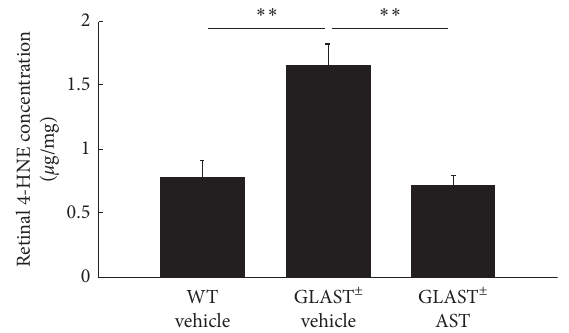
Figure 4: Retinal concentration of 4-HNE after AST administra- tion. Note that the concentration of 4-HNE was elevated in Glast ± mice compared with WT mice, but was significantly sup- pressed following AST administration. ∗∗ P < 0 .